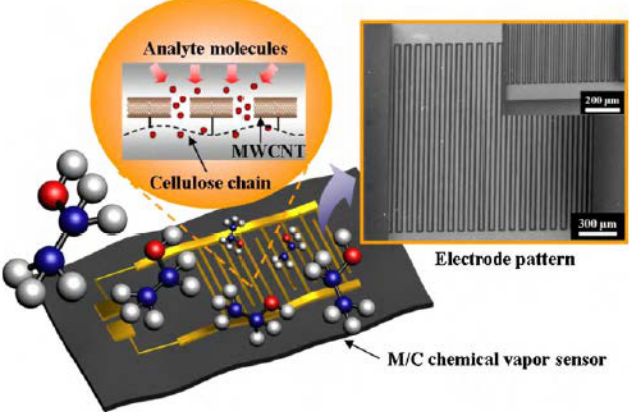
Figure 6. Schematic of chemical vapor sensor made with M/C paper and IDT shaped electrode (reproduced with permission [105]).